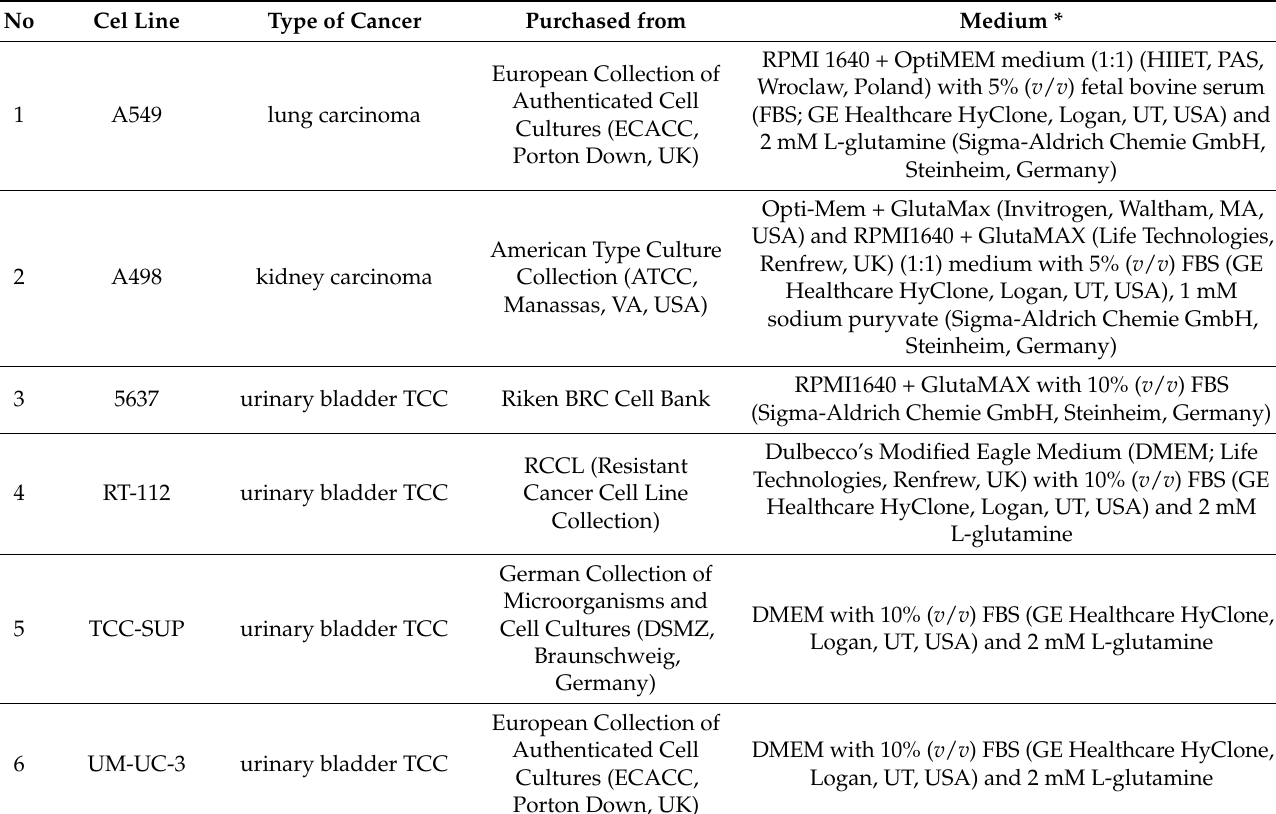
Table 2. Cell lines and culture media used in the present